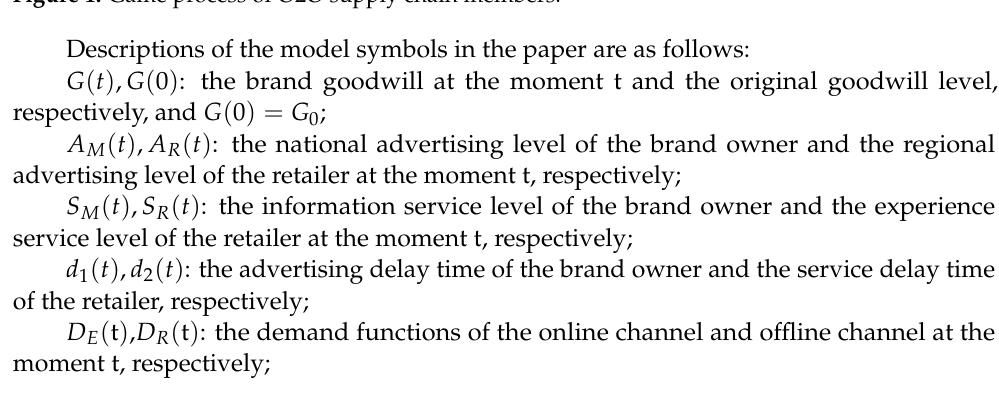
Figure 1. Game process of O2O supply chain members.